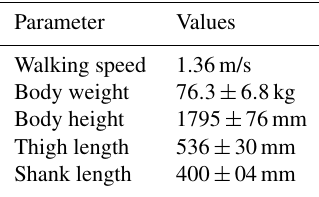
Table 1. Anthropometric measurements and gait